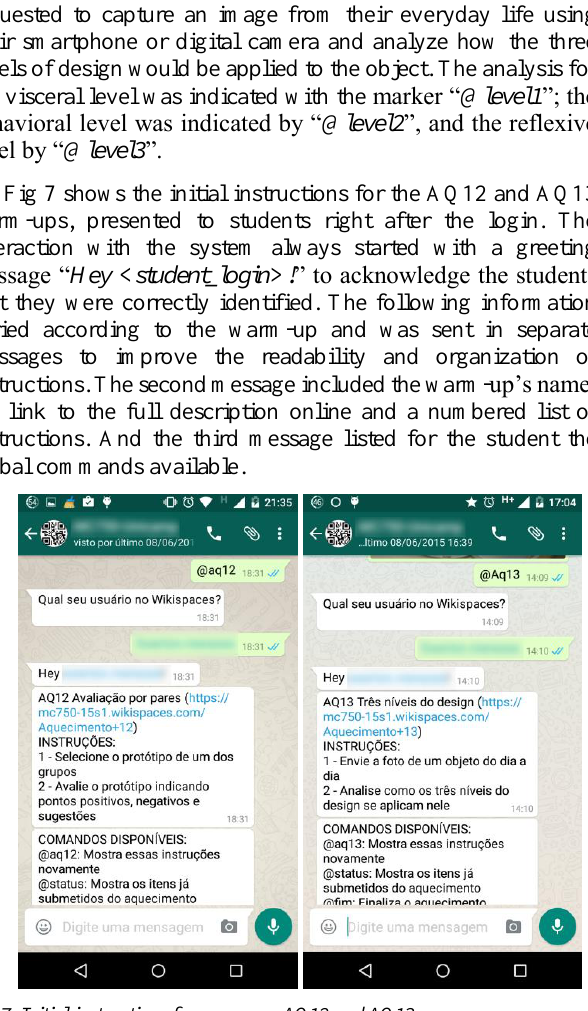
Fig 7. Initial instructions for warm-ups AQ12 and